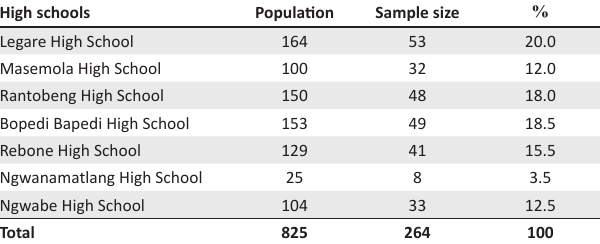
TABLE 1: Population and sample size of the